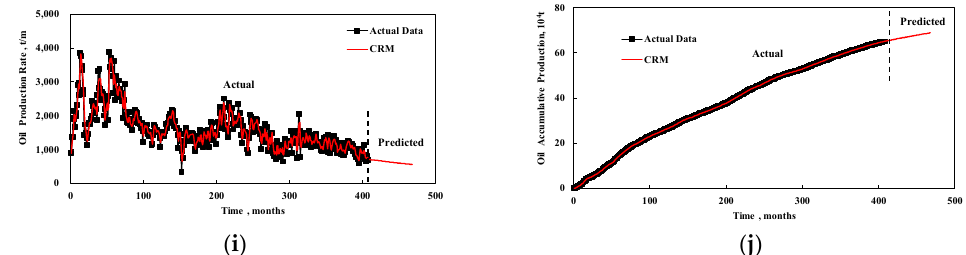
Figure 6. Comparison between the actual oil production data and the calculated oil production data by combining modified CRM and the waterflooding characteristic equation. ( a ) Producer 1499, ( b ) Producer 1500, ( c ) Producer 1501, ( d ) Producer 1511, ( e ) Producer 1512, ( f ) Producer 1519, ( g ) Producer 1520, ( h ) Producer 1521, ( i ) Monthly liquid production of the well group, ( j ) Accumulative liquid production of the well group.